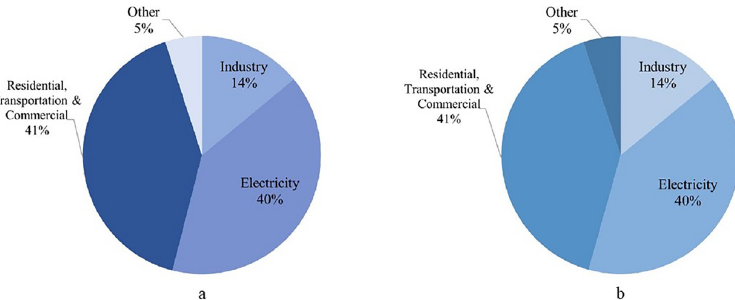
Fig 5. Comparison of sector wise carbon dioxide (CO 2 ) emissions from the model to global sector wise carbon emissions for 2009 a: Data from UN energy statistics handbook (2009) b: GGSM model.